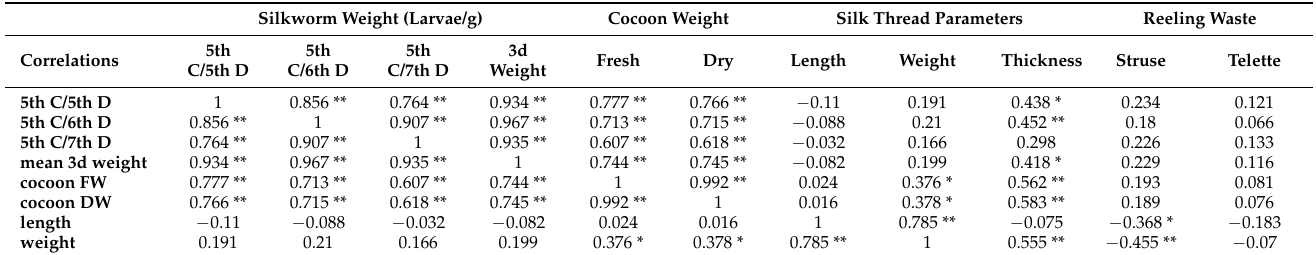
Table 6. Pearson’s correlation coefficient between silkworm, cocoon, and raw silk parameters in relation to the macro- and microelements ( n = 32) in mulberry leaves